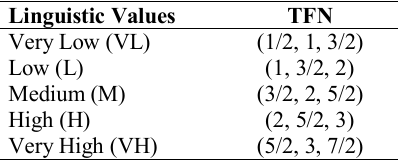
Table1. Linguistic values and values in TFN